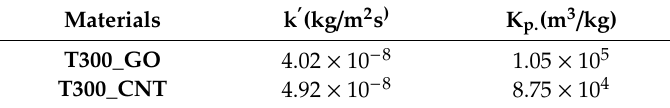
Figure 2. Reciprocal plot of reaction rate and respective concentration of T300_GO (dashed line) and T300_CNT (solid line). Table 2. Experimentally estimated kinetic parameters k’ and K